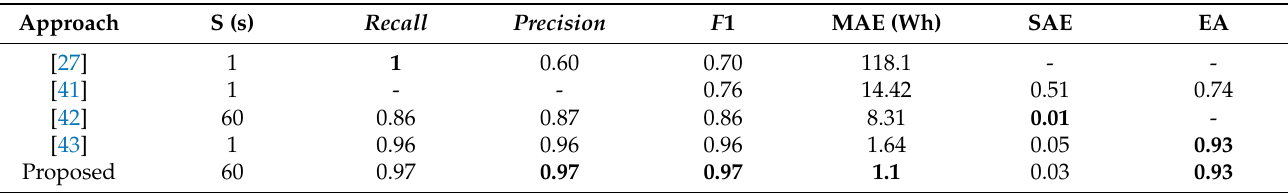
Table 16. Washing machine performance